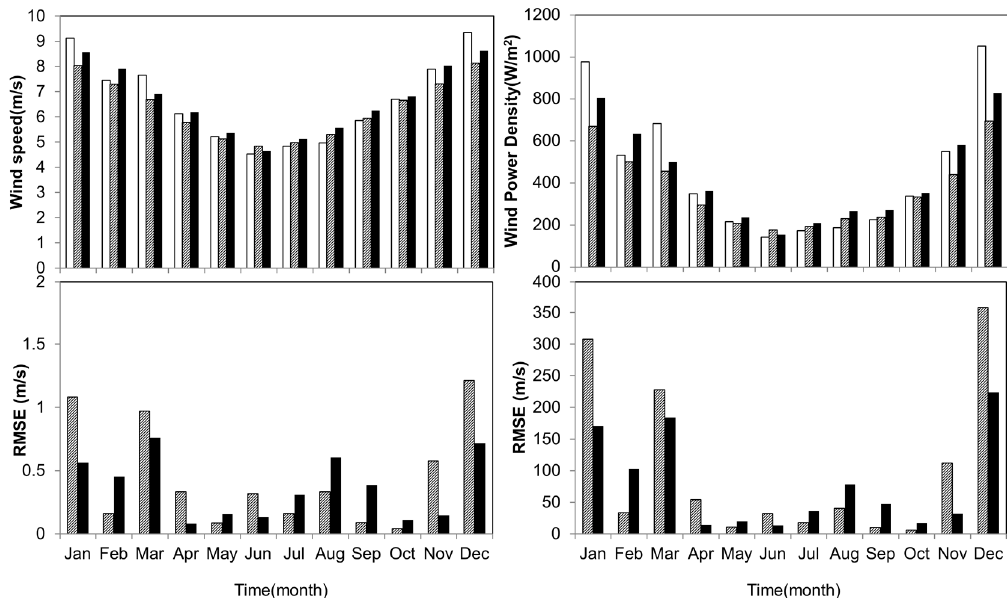
Figure 7. Variability of satellite-observed (white box) and hindcast wind speeds (gray box; the seasonally varying climatology, black box: optimal lagged multiple regression (OMLR)-based wind speed forecasting model) at 10 m above sea level (asl) and wind power density (WPD) at 80 m asl for the model evaluation period. The gray and black dashed lines indicate the annual average RMSE for the wind speeds and the WPD taken from the climatology and the OMLR, respectively.